Question: Describe this figure in one sentence.
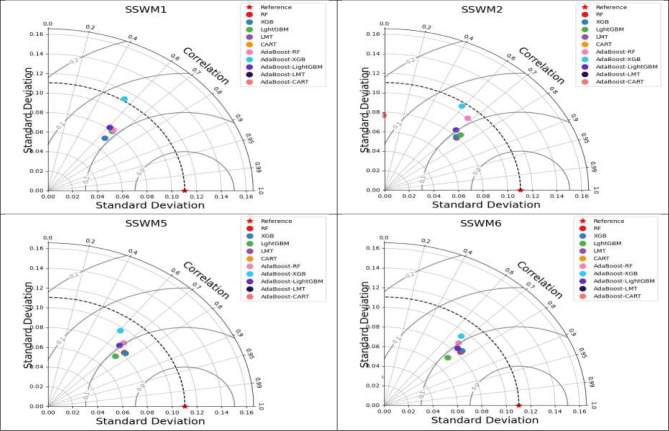
Answer: Taylor diagram showing the relationship of correlation coefficient between actual and predicted SSW of the Moga region during testing of the models.